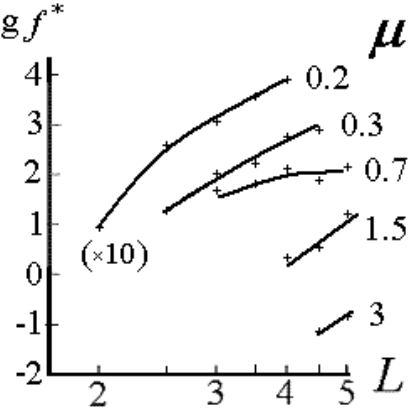
Figure 2. Functions f ∗ ( L ) for protons with different µ (from 0.2 to 3keVnT − 1 ) calculated with Explorer-45 data from Fritz and Sp- jeldvik (1981) for the quiet period of 1–15 June 1972. Here µ is given in kiloelectronvolt per nanotesla. The value of f ∗ (s 3 cm − 6 ) is 1.836 × 10 30 f . The curve for µ = 0.2keVnT − 1 is raised above the other curves by 1 order of